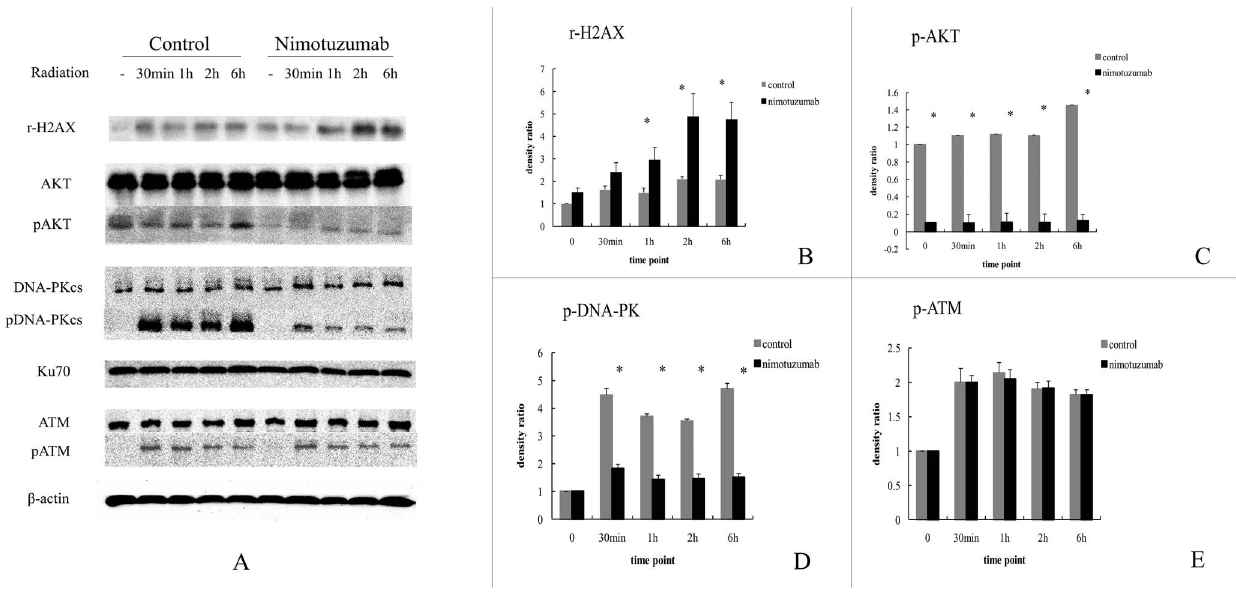
Figure 5. Time kinetics of DNA damage repair related proteins after radiation in A549 cells pretreated with nimotuzumab. (A) A549 cells pretreated with or without nimotuzumab for 24 h were irradiated with 4 Gy. Cells were harvested and lysed at indicated times. The lysates at indicated times underwent electrophoresis and were incubated with antibodies against c -H2AX, AKT, pAKT, DNA-PKcs, pDNA-PKcs, Ku70, ATM, pATM and b -actin. (B–E) Quantification of bands based on densitometric analysis. The results are relative density ratio to the unirradiated control. Each bar represents the mean 6 SD of three independent experiments. * indicates significant difference (P , 0.05). doi:10.1371/journal.pone.0070727.g005 were left unrepaired after radiation in nimotuzumab pretreated Next, we investigated how nimotuzumab inhibited the radia- cells, which ultimately led to the cell apoptosis, and showed a tion-induced DSBs repair. DNA-PKcs is a critical protein involved linear correlation with radiation doses or post-radiation time. in non-homologous end-joining repair of DNA DSBs. The